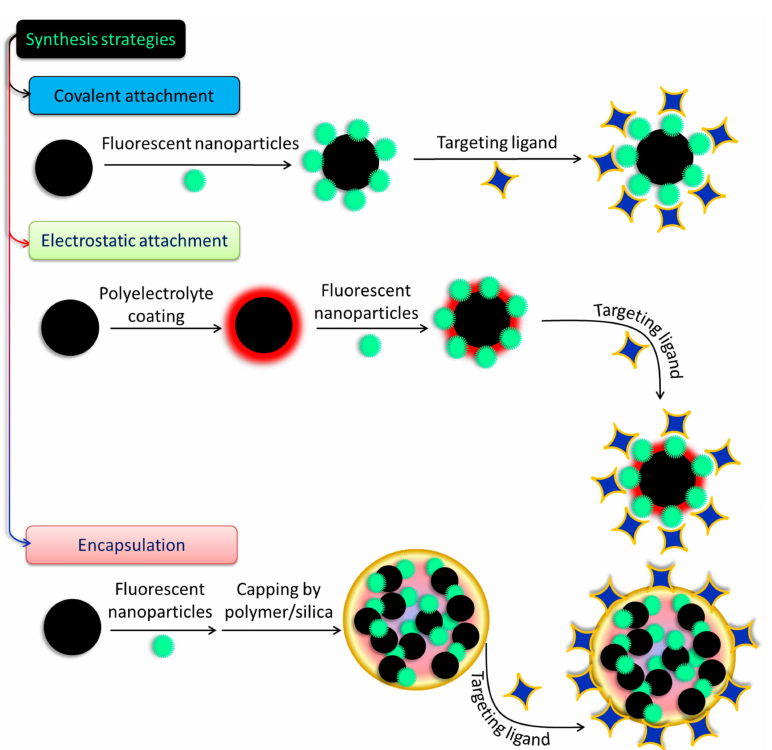
Figure 5. Different approaches to prepare fluorescent-nanoparticle-decorated magnetic nanostruc-